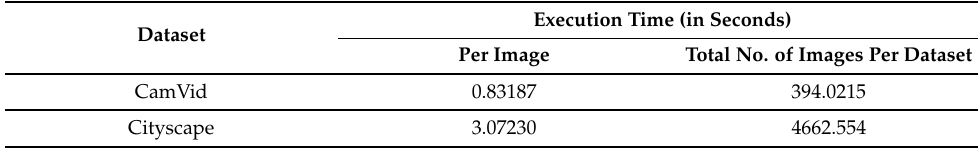
Table 5. Execution time for the segmentation